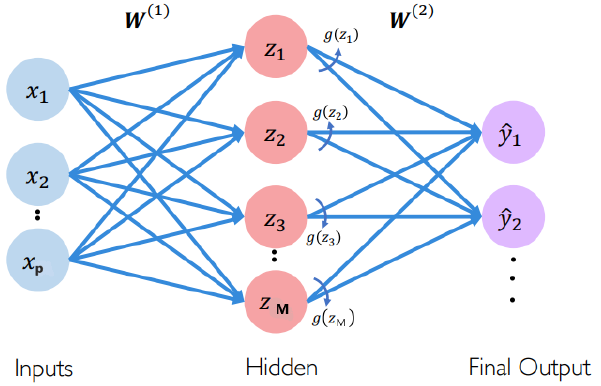
Figure 2. Diagram of a single hidden layer, feedforward neural